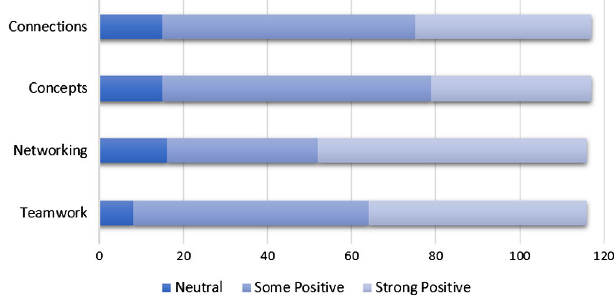
FIG. 4. Survey responses from all students on the impact of participating in outreach programs on recognizing connections between topics, their depth of conceptual physics understanding, networking within the department, and development of teamwork skills. Omitted from the figure were two additional choices of “ strong negative ” and “ some negative. ” No responses were recorded for strong negative. One some negative response was received for both networking and